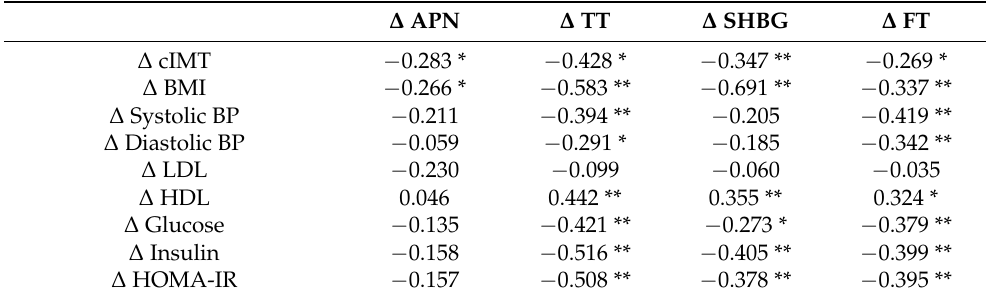
Table 3. Correlation coefficient of changes in adiponectin and androgens with other